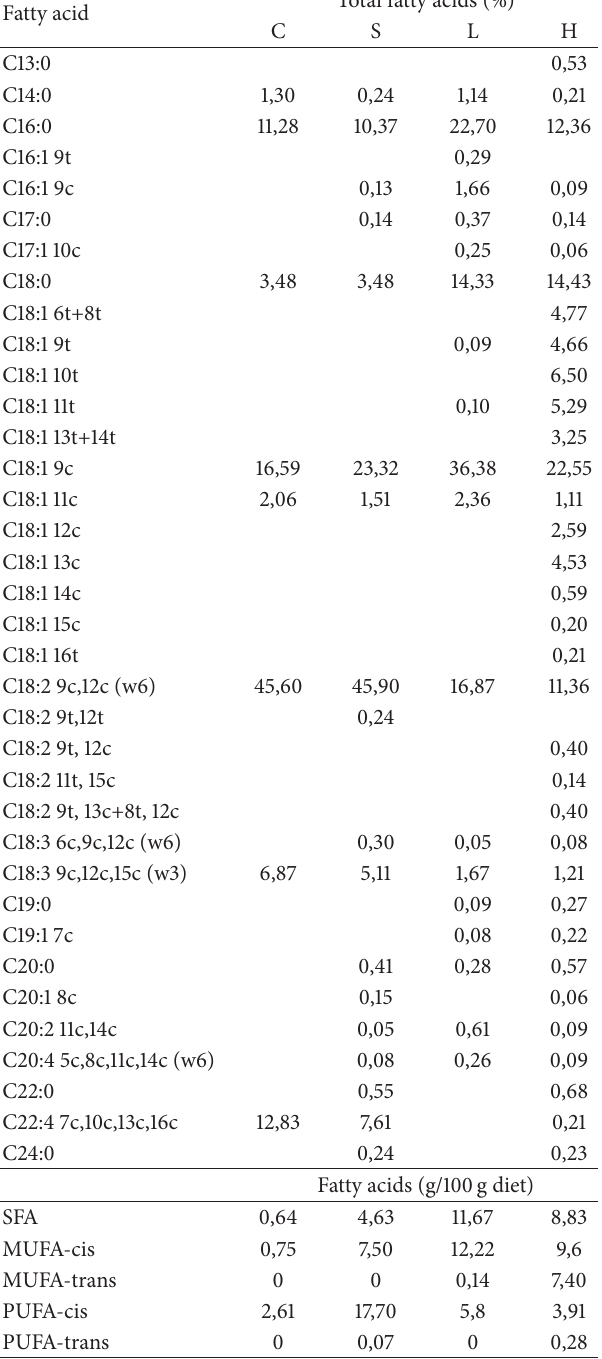
Table 2: Fatty acid composition, as percent of total lipid content, of the control (C), soybean (S), lard (L), and hydrogenated vegetable oil (H) diets prepared according to AIN-93.